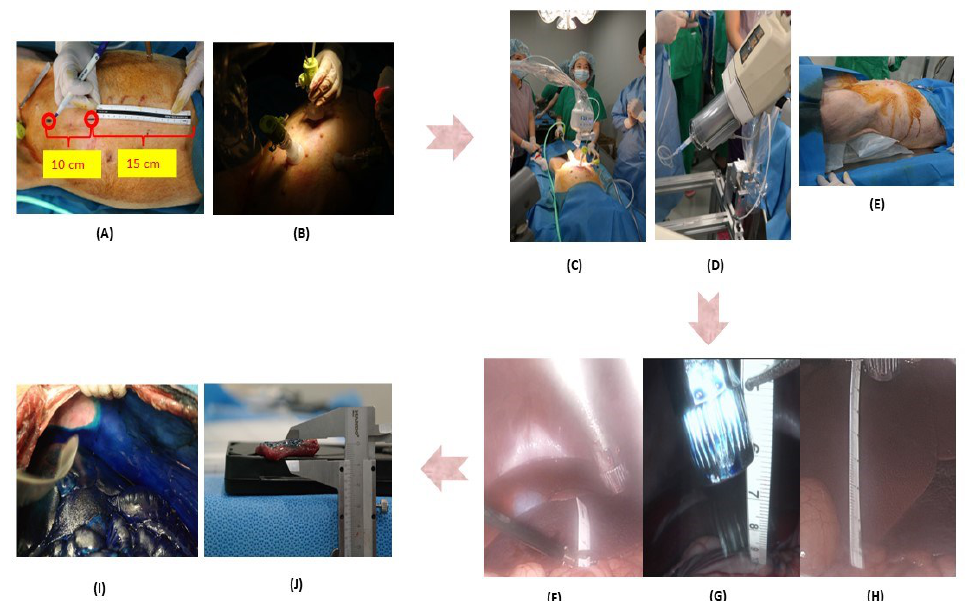
Figure 1. The experimental process for evaluating the optimal nozzle position and patient posture for rotational intraperitoneal pressurized aerosol chemotherapy (RIPAC): ( A ) insertion positions of two 12 mm bladeless trocars (the first position was 15 cm below the xyphoid process, and the second position was located 10 cm further below); ( B ) the view after insertion of two 12 mm bladeless trocars; ( C ) the view after installation of RIPAC system; ( D ) a high-pressure injector for spraying 150 ml of 1% methylene blue as aerosol; ( E ) Trendelenburg position of pigs; Dreampen ® (Dreampac Corp., Wonju, Republic of Korea) placed at a depth of 2 cm ( F ), 4 cm ( G ), and 7 cm ( H ) from the visceral peritoneum; Evaluation of the distribution ( I ) and penetration depth ( J ) of 1% methylene blue after RIPAC.